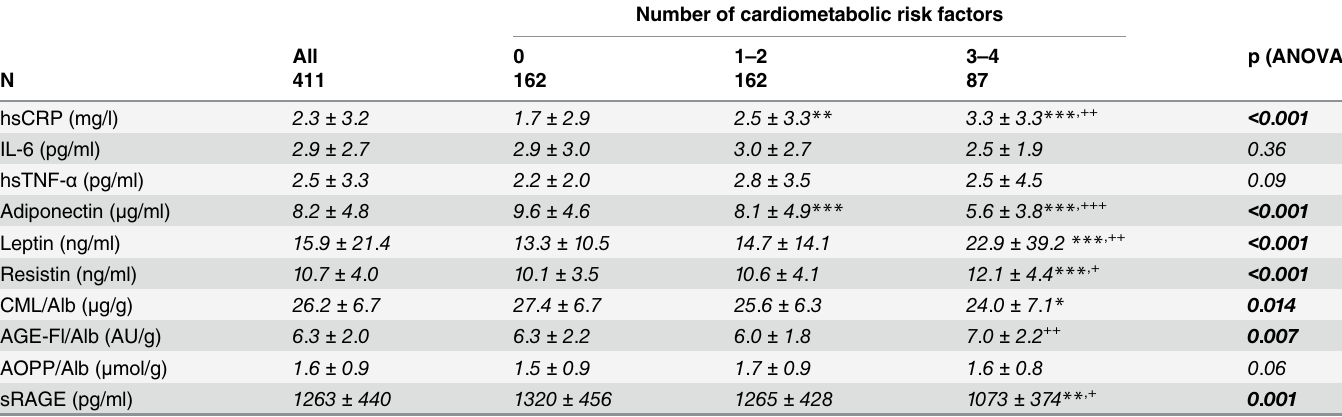
Table 2. Cohort characteristics: inflammatory and oxidative stress markers, adipokines and advanced glycation end